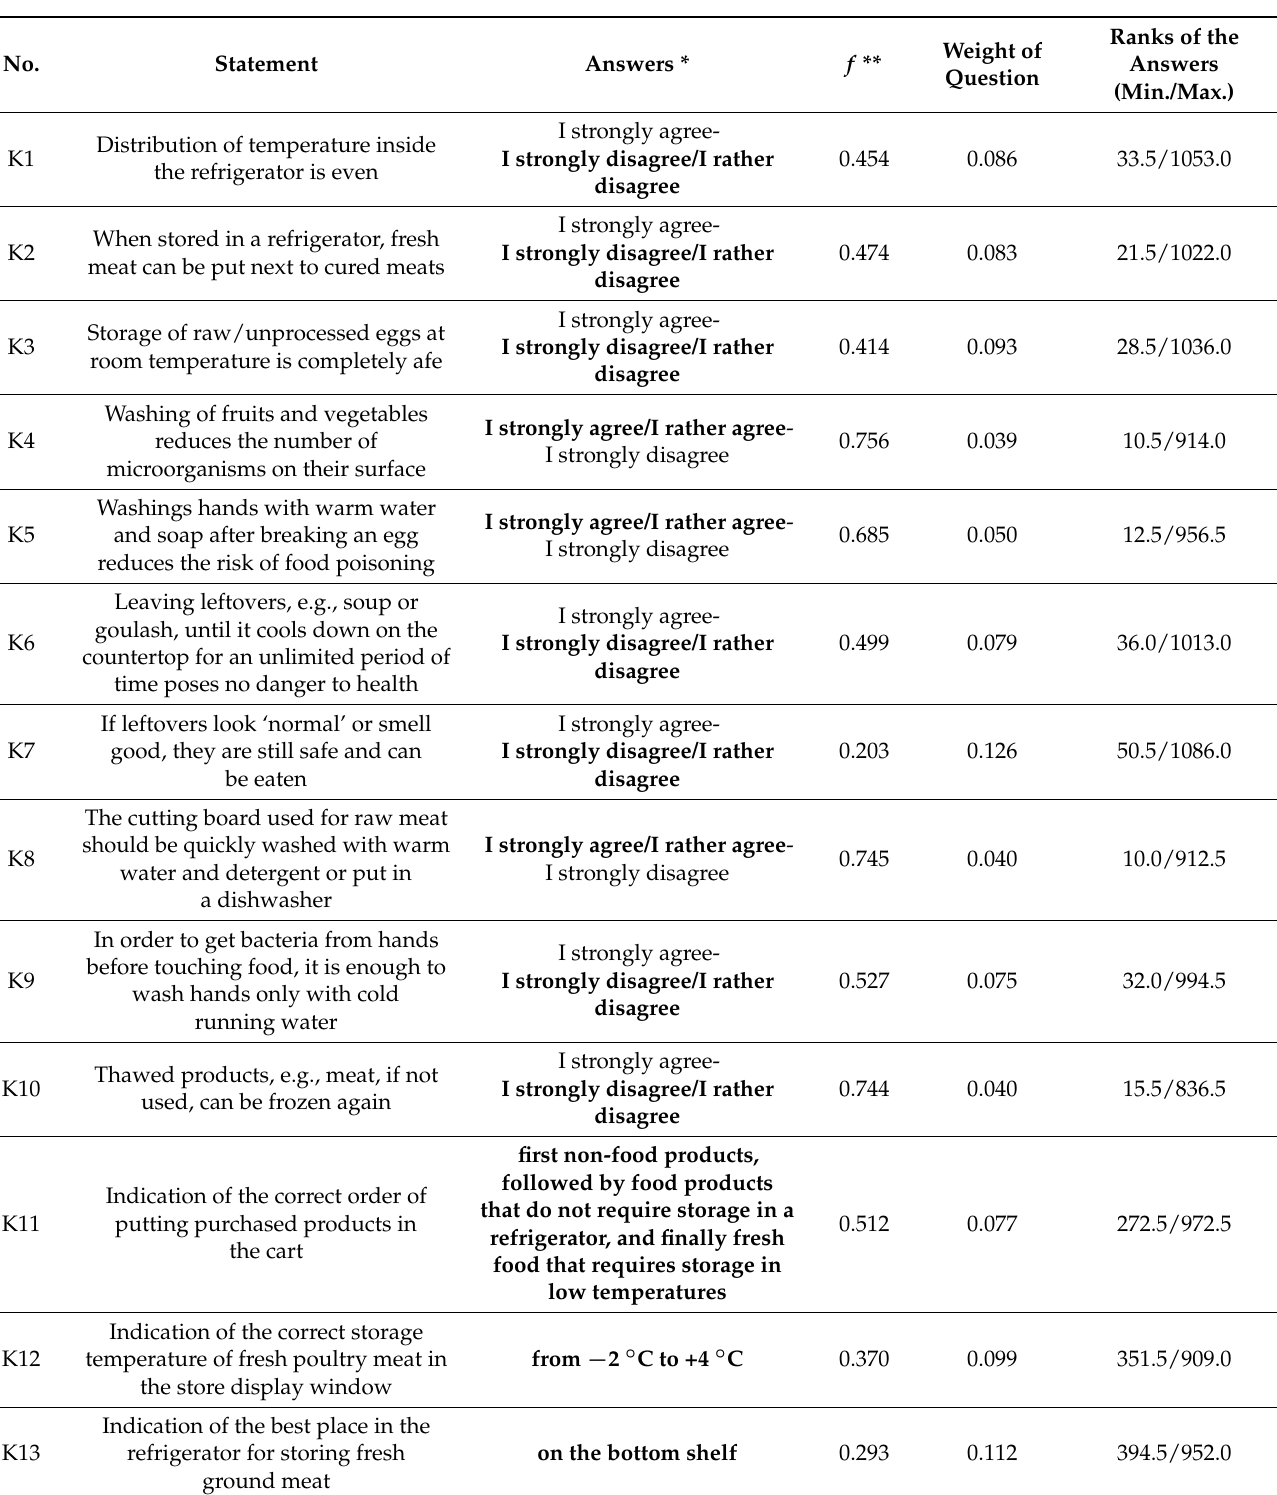
Table A1. A set of questions taken into account while constructing a synthetic variable concerning the knowledge along with the calculated weights and